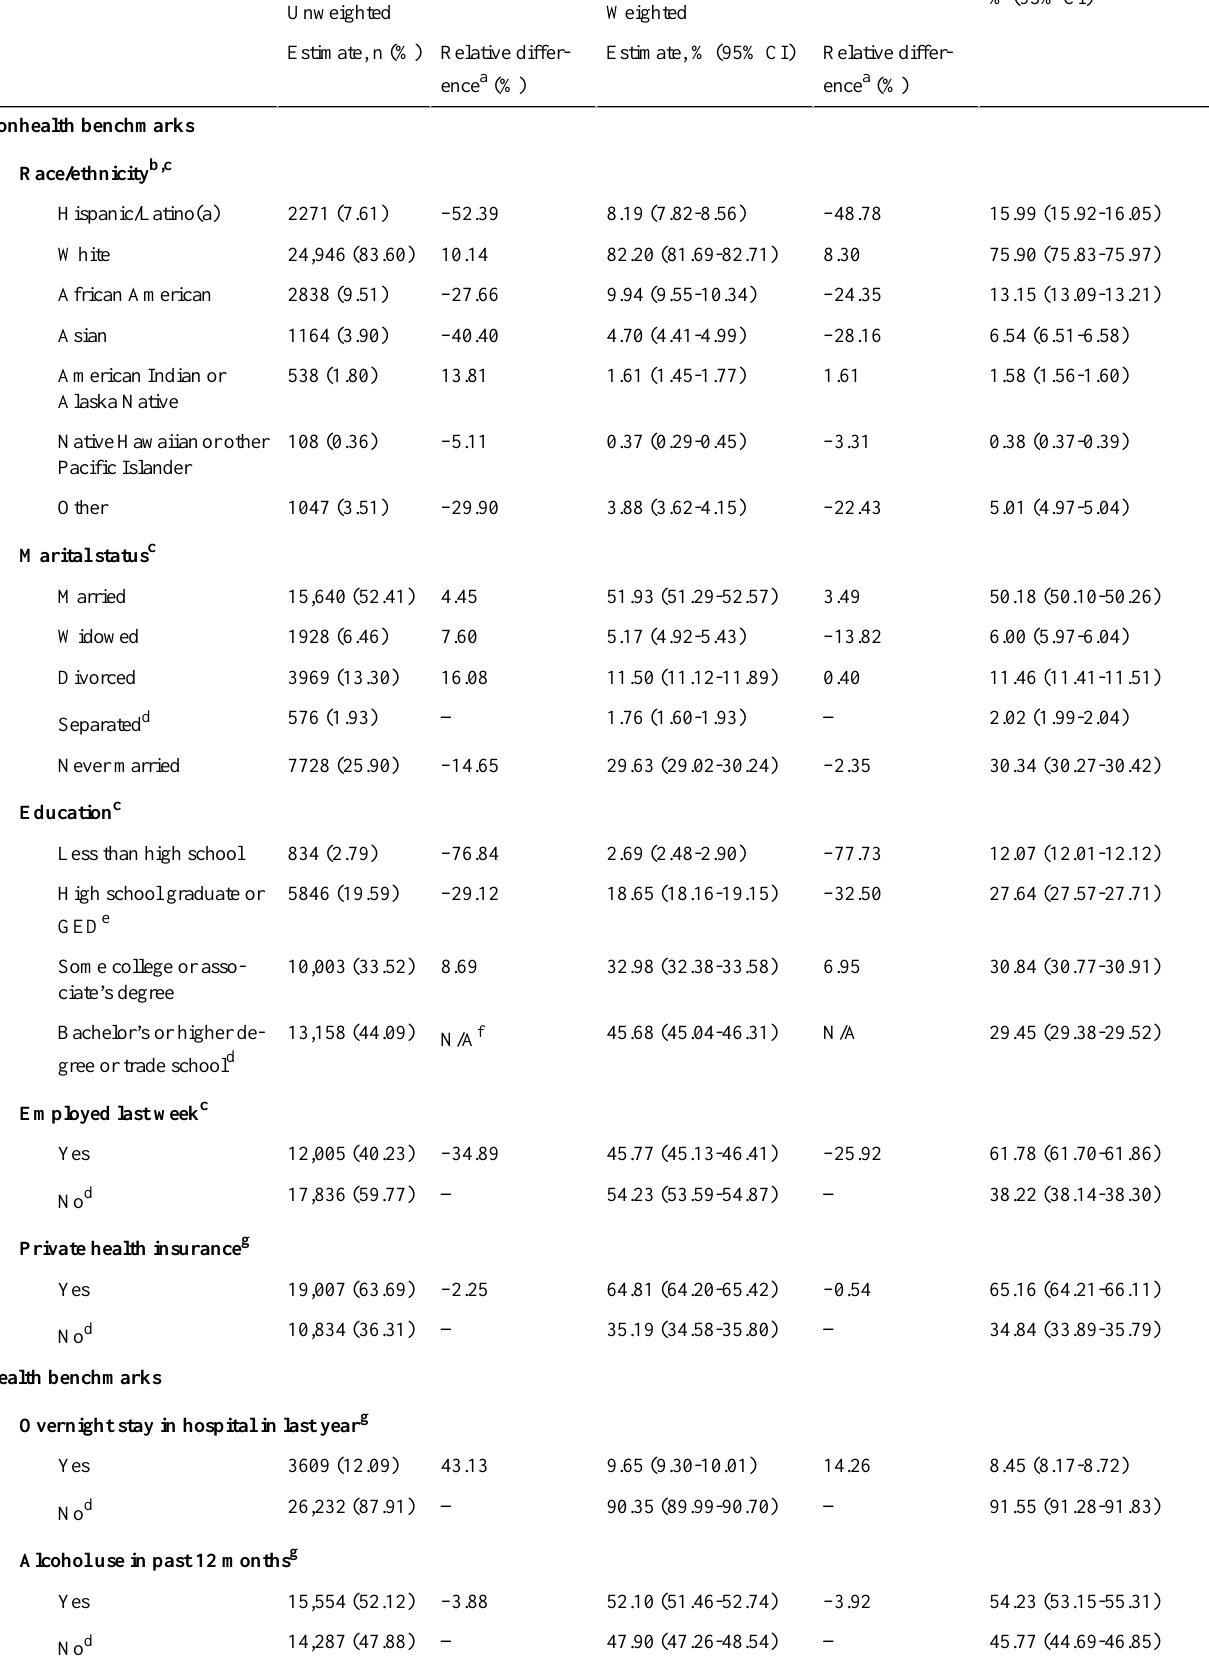
National survey